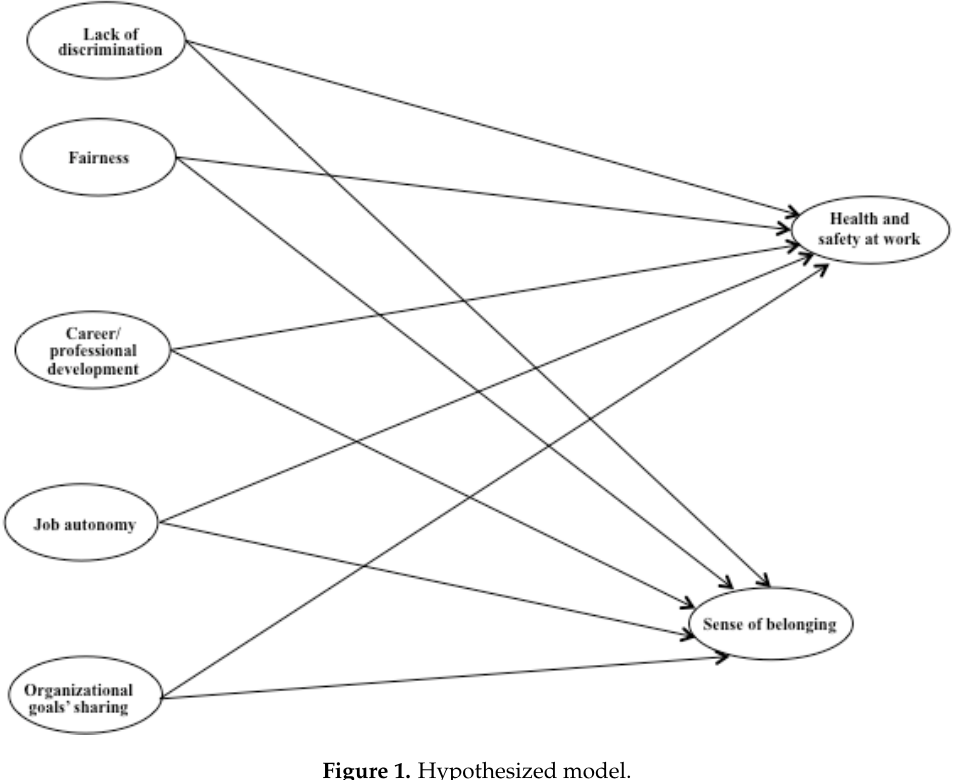
Figure 1. Hypothesized model.